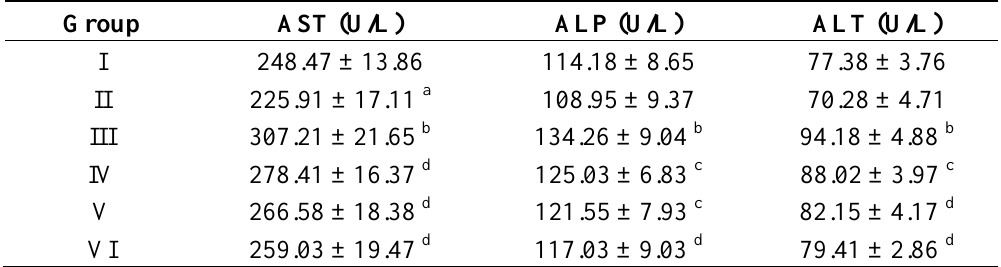
Table 3. Effect of tea polyphenol on serum serum aspartate transaminase (AST), alanine aminotransfere (ALT) and alkaline phosphatase (ALP) activities.